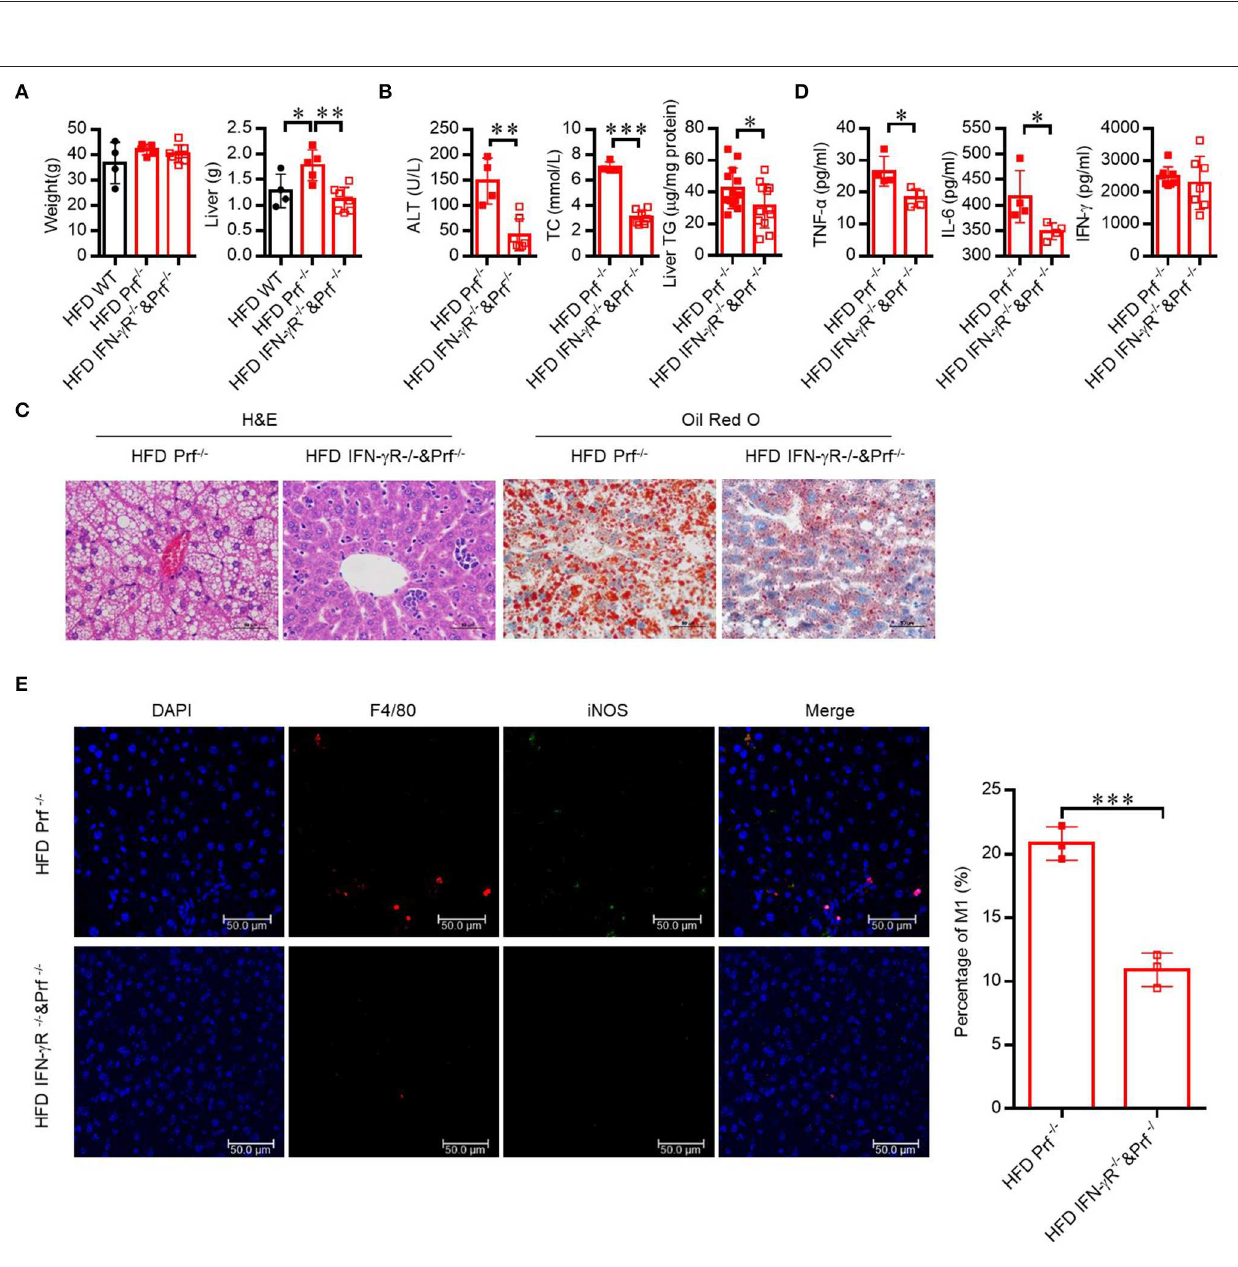
FIGURE 6 | Hepatic steatosis in Prf − / − mice is dependent on IFN- γ mediated inflammation. Prf − / − and IFN- γ R − / − and Prf − / − mice were fed HFD for 10 weeks. (A) Body and liver weight were measured ( n = 4–7). (B) Serum levels of ALT (left panel, n = 4–7), cholesterol (middle panel, n = 4–7), and liver TG (right panel) were measured ( n = 12–13). (C) Representative images of liver sections stained with H&E (left) and Oil red O (right). (D) TNF- α , IL-6, and IFN- γ levels were detected in liver culture supernatants ( n = 4). (E) Representative immunohistochemistry of DAPI (blue), F4/80 (red), iNOS (green), and co-localization (merged image) in liver, and the percentage of M1/M (refers to iNOS + F4/80 + cells/ F4/80 + cells) was calculated (right). The data shown in each panel of the figures were collected from a single experiment, and each experiment was repeated for at least three times and rendered consistent results. Means ± SEM, * p < 0.05; ** p < 0.01, *** p < 0.001.